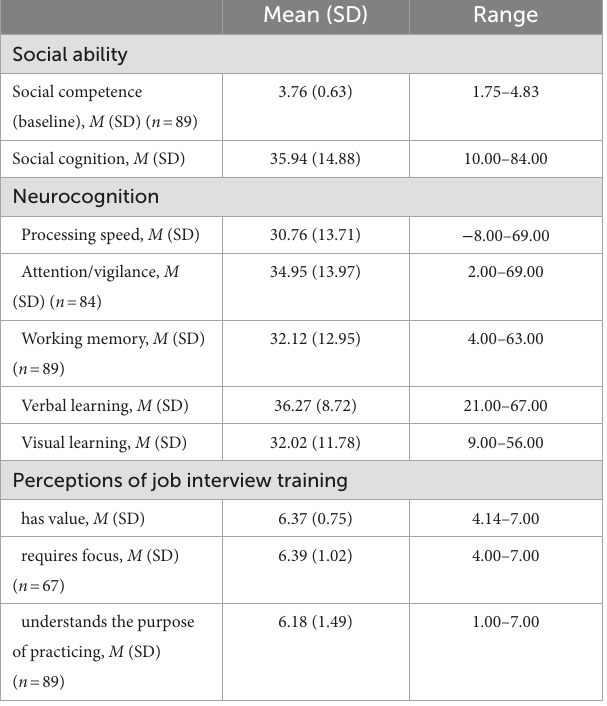
TABLE 2 Descriptive statistics of social, cognitive, behavioral, and VR-JIT engagement and performance variables ( n = 90).